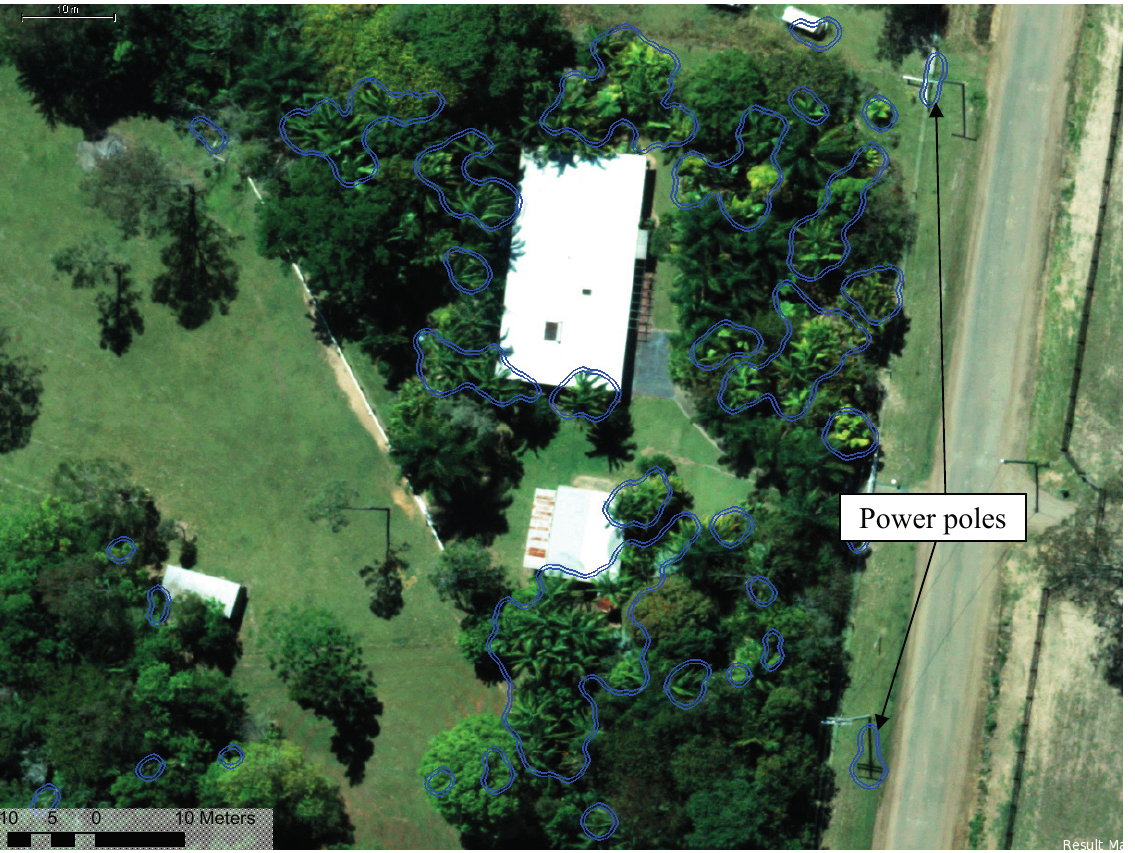
Figure 15. Palms occurring as false positives. Power poles and their shadow also